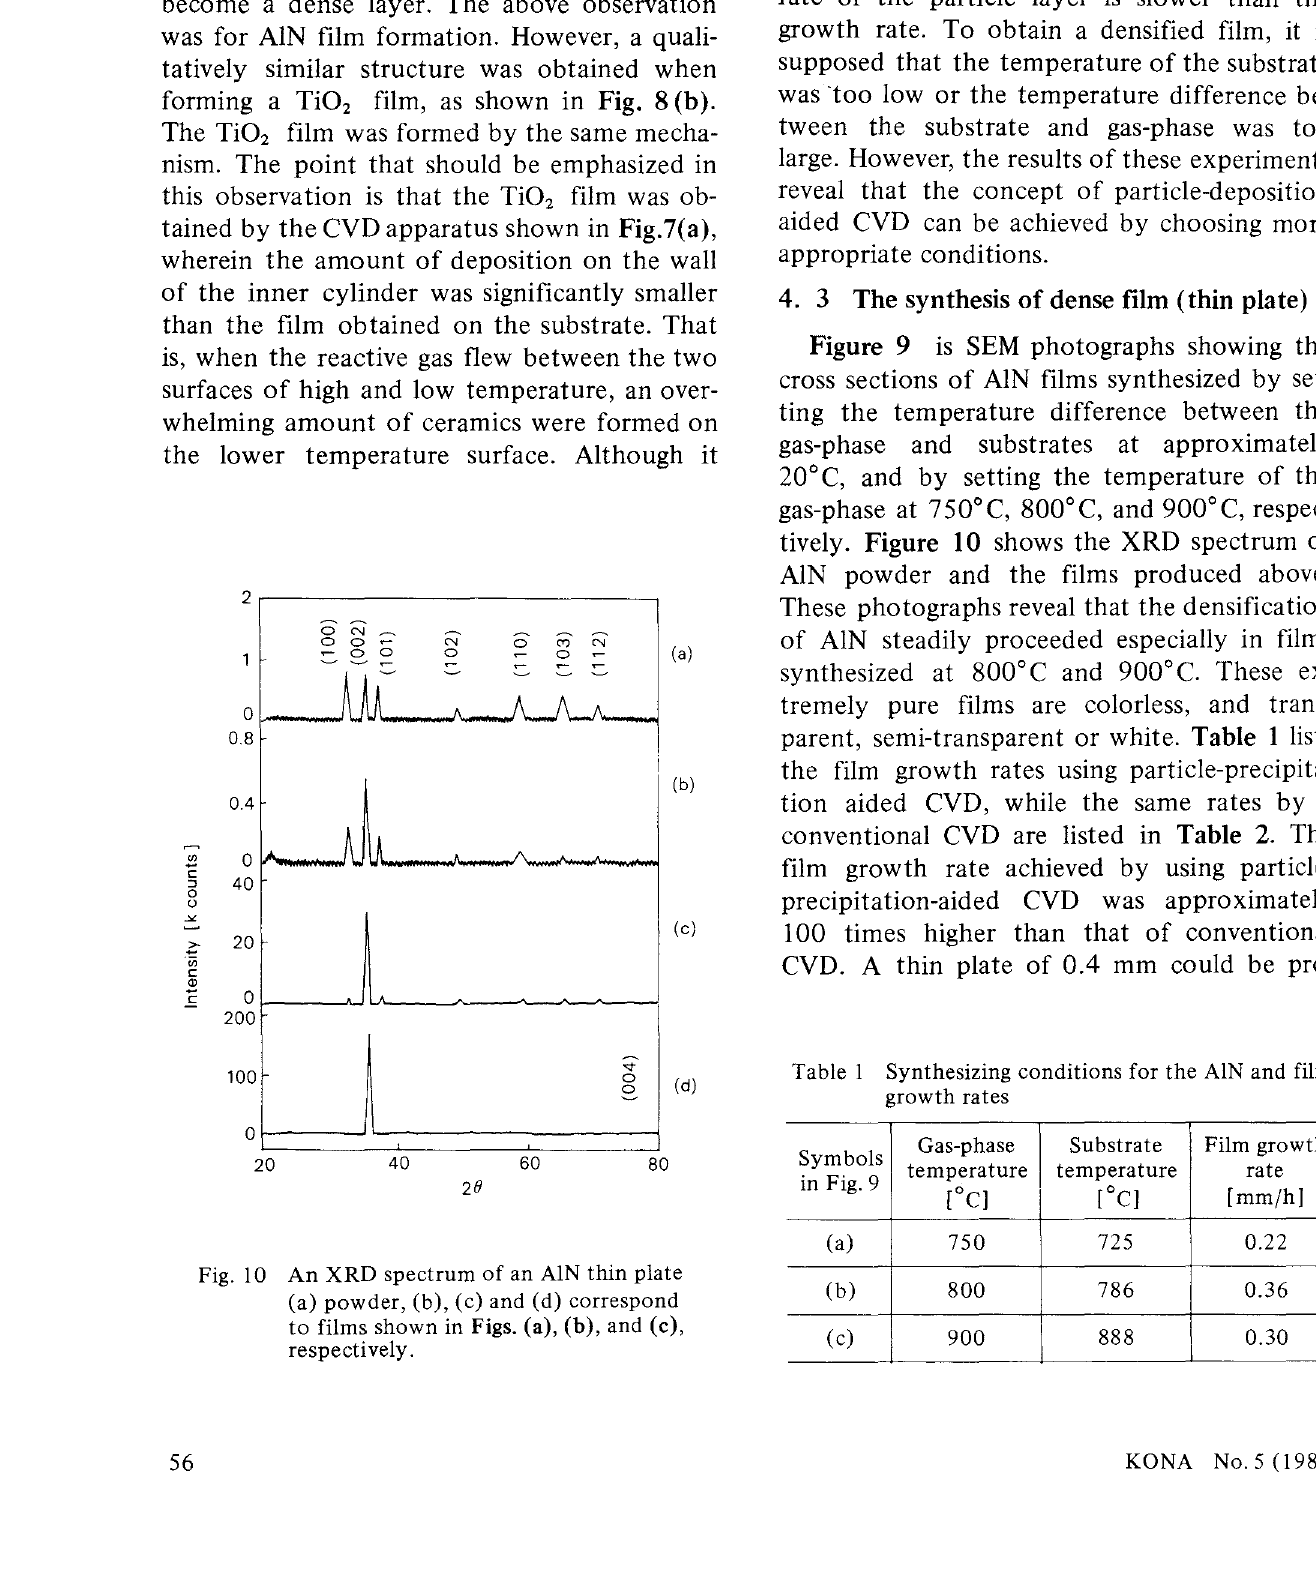
Fig. 10 An XRD spectrum of an AlN thin plate (a) powder, (b), (c) and (d) correspond to films shown in Figs. (a), (b), and (c),